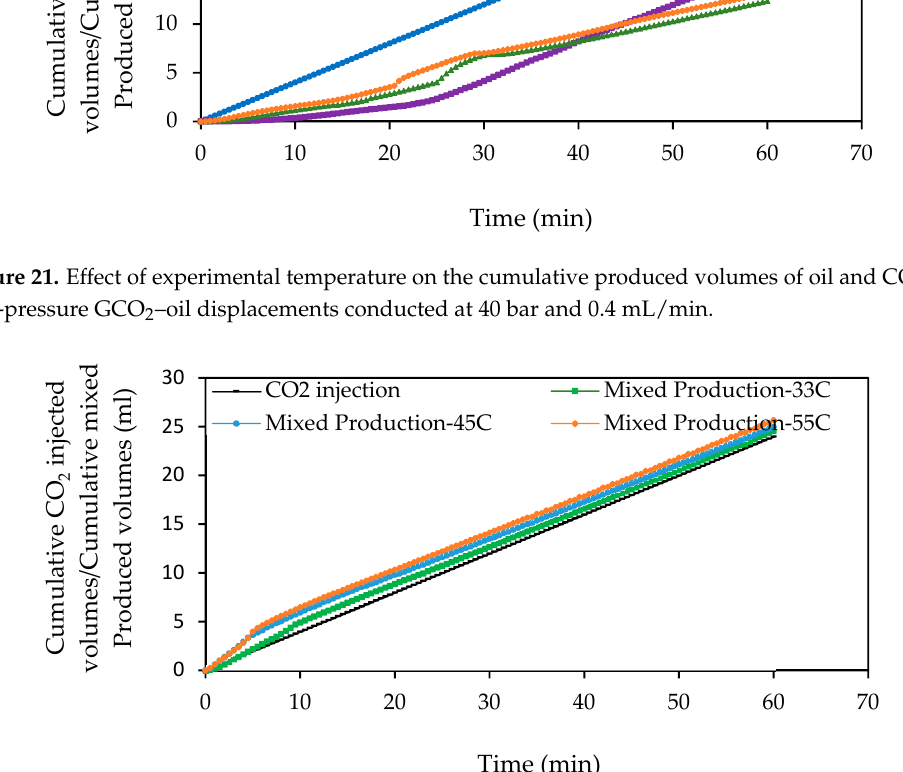
Figure 22. Effect of experimental temperature on the cumulative produced volumes of oil and CO 2 for high-pressure GCO 2 –oil displacements conducted at 70 bar and 0.4 mL/min.